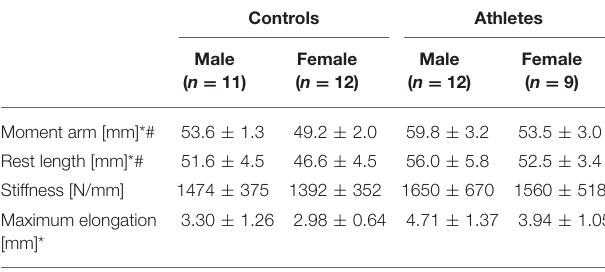
FIGURE 3 | Mean values and standard error (error bars) of patellar tendon force (A) , normalized stiffness (B) and strain during maximum isometric contractions (C) of male (white) and female (black) adolescent controls and volleyball athletes. *Significant difference between athletes and controls, # significant difference between males and females, p < 0.05. TABLE 3 | Patellar tendon properties of adolescent controls and volleyball